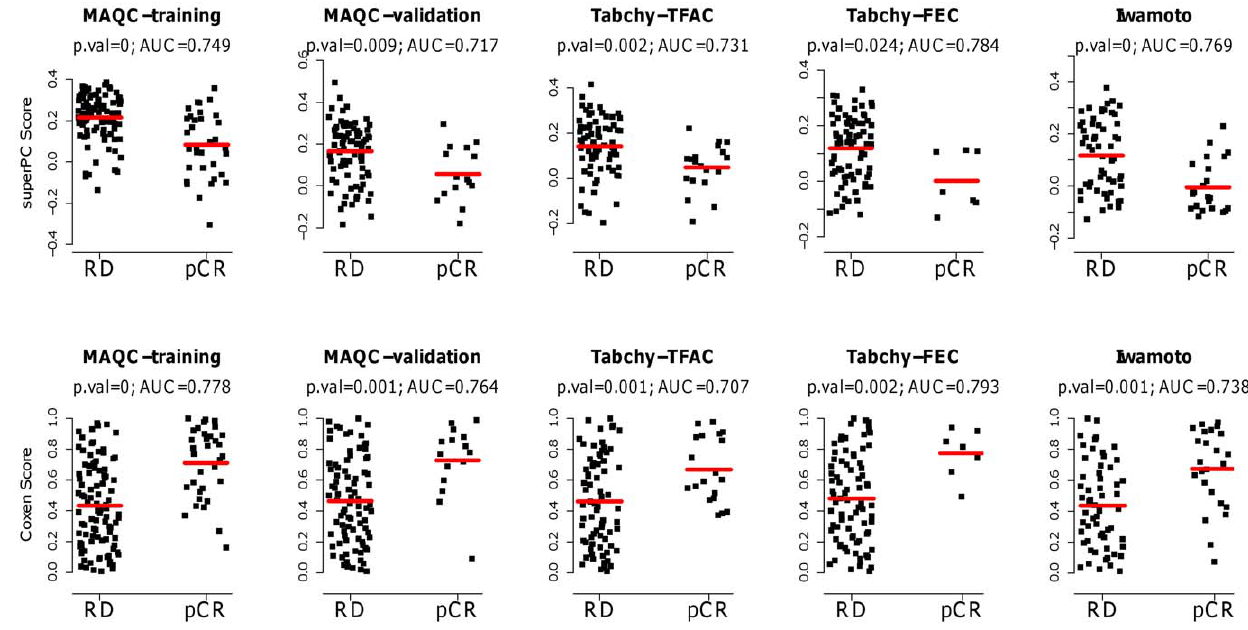
Figure 3. Distributional difference between prediction scores calculated by the superPC or COXEN methods from the Neve training set for responders (pCR, pathologic complete response) and non-responders (RD, residual disease), with p-value and AUC. In the top row, the prediction scores are calculated by the superPC method, and in the bottom row, the prediction scores are calculated by the COXEN method. Red lines represent median prediction scores in each group.